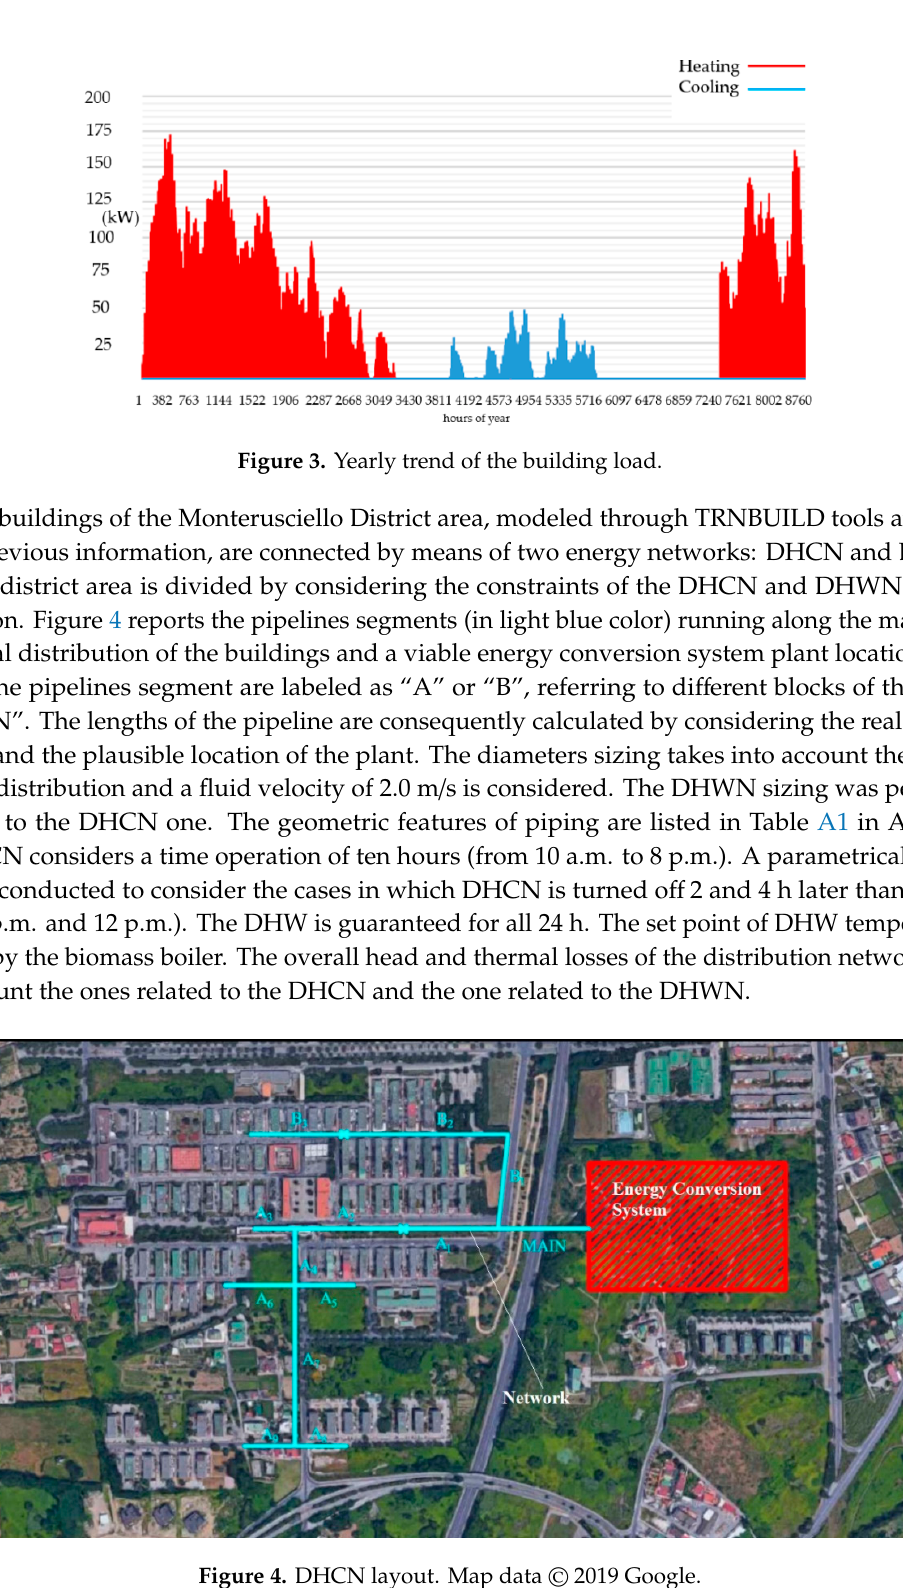
Figure 4. DHCN layout. Map data © 2019 Google.